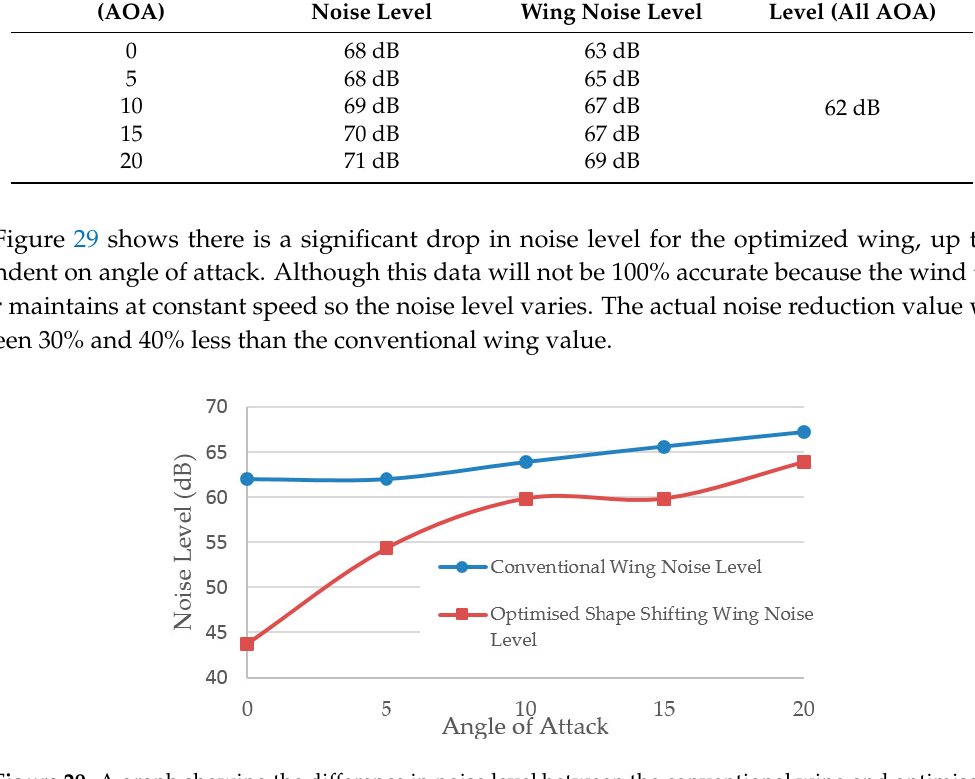
Figure 29. A graph showing the difference in noise level between the conventional wing and optimised morphing wing.